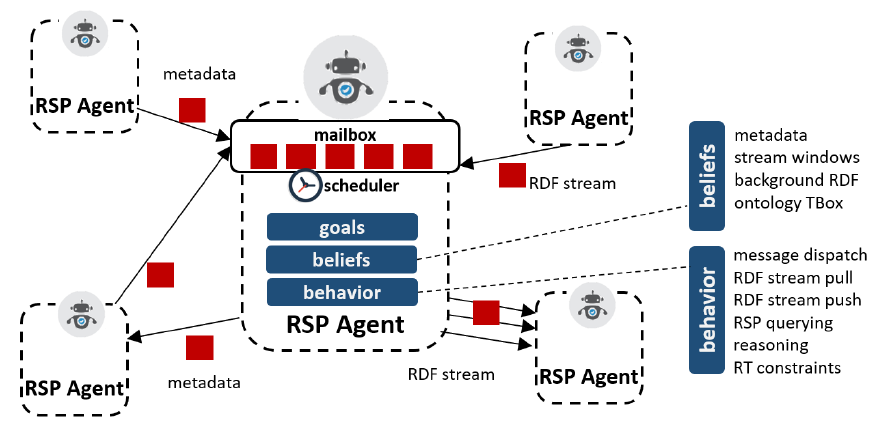
Figure 6. RSP agents architecture. Each agent encapsulates beliefs, goals, and behavior, and manages incoming messages through its mailbox. The execution of real-time constrained tasks is governed by an internal scheduler, and the constraints themselves are included in the agent behavior. Ontologies and vocabularies are included as part of the agent beliefs or knowledge, as well as the contents of dynamic stream that the produce/consume. Interactions among RSP agents happen through RDF message exchange of either metadata or continuous RDF